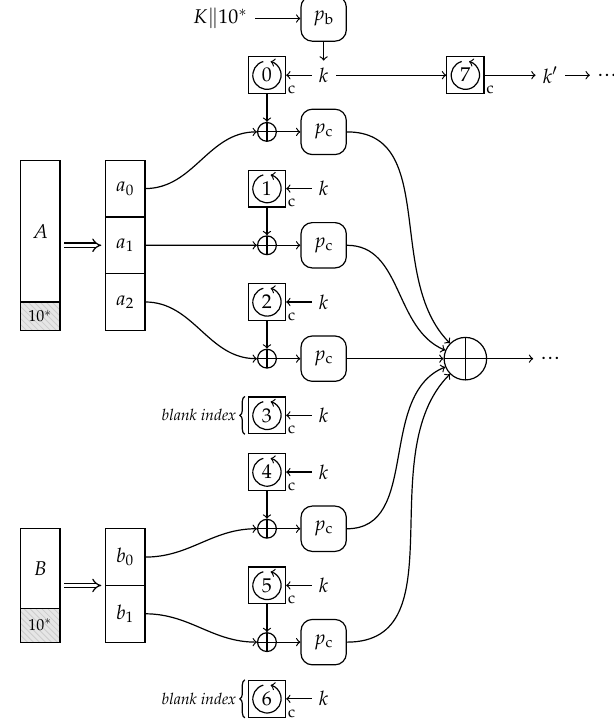
Figure 2: A closer look at the compression of example string sequence B ◦ A in Farfalle. 2 higher than that for the last block of M ( j − 1) . There is hence a block index value for which there is no contribution to the accumulator. We call this a blank index , a concept elucidated in Figure